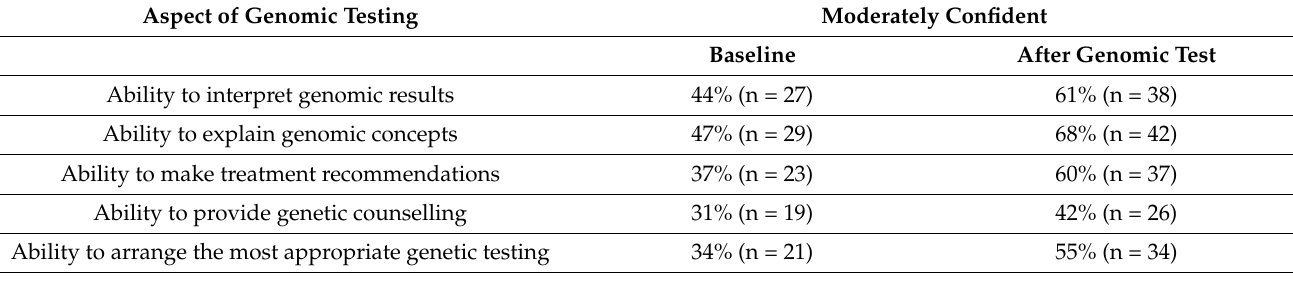
Table 3. Neurologist surveys- Moderate confidence ability for different aspects of genomic testing from baseline to after genomic testing as well as qualitative comments regarding the MDT